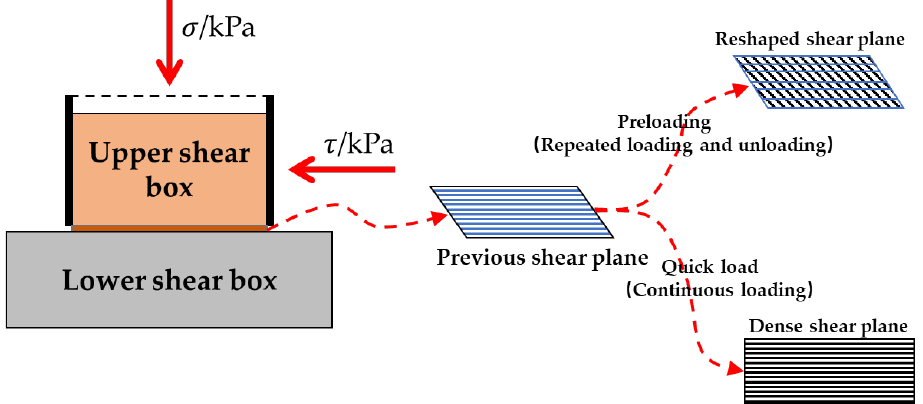
Figure 19. Schematic diagram of the interface remodeling and compaction mechanism.